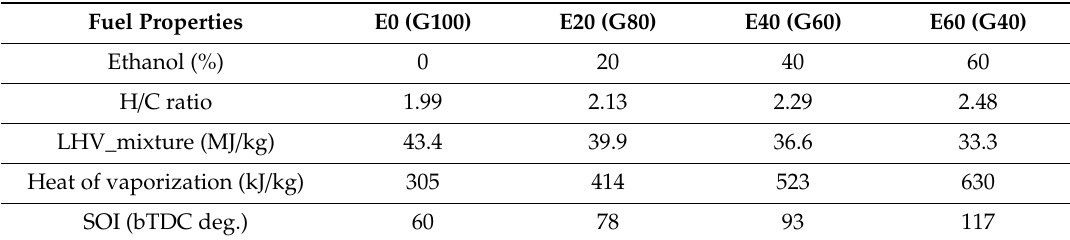
Table 4. Fuel properties and start of injection (SOI) for ethanol blending ratio.